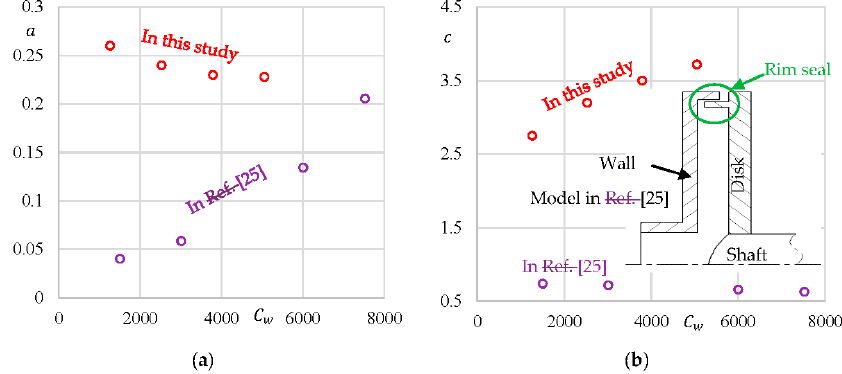
(cid:16) (cid:17) Re ϕ by measurements: ( a ) C w = 1262; ( b ) C w = 2525; ( c )